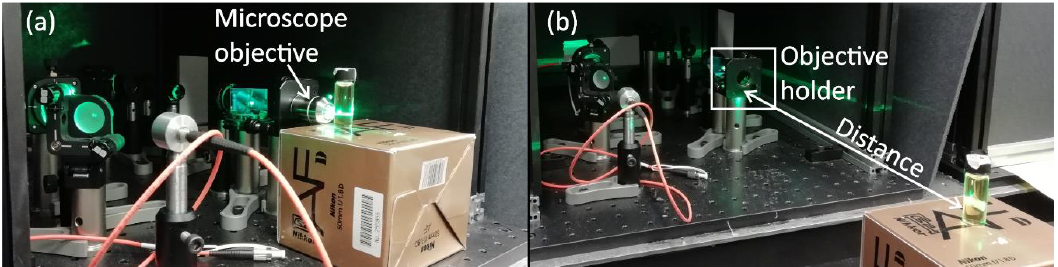
Figure 3. Photographs of the CMOS SPAD-based ( a ) Raman microscope and ( b ) distance-resolving Raman radar.